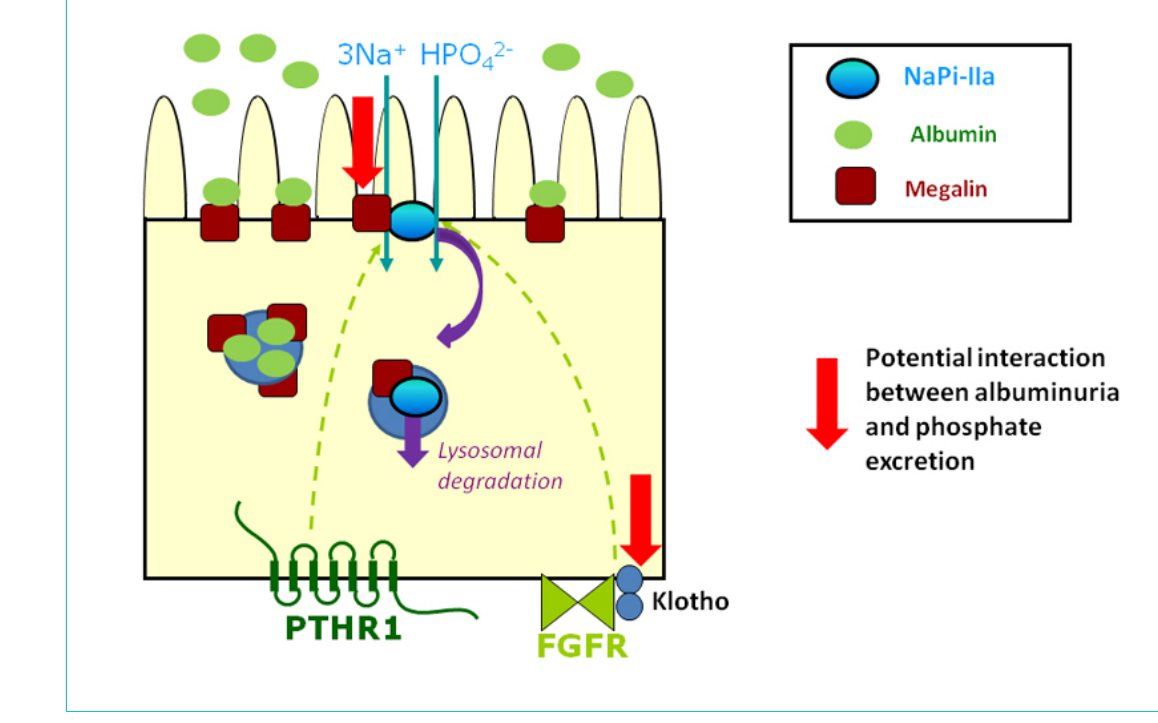
Figure 2: Molecular pathway linking albuminuria to phosphate retention. NaPi-II: sodium phosphate co-transporter type IIa, PTHR1: PTH re- ceptor 1; FGFR: FGF